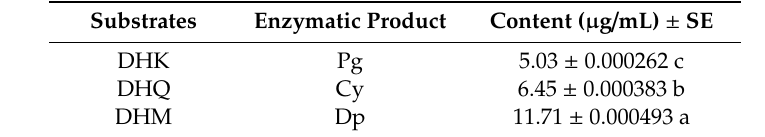
Table 1. Enzymatic experiment of MaDFR catalyzing the formation of corresponding products by three